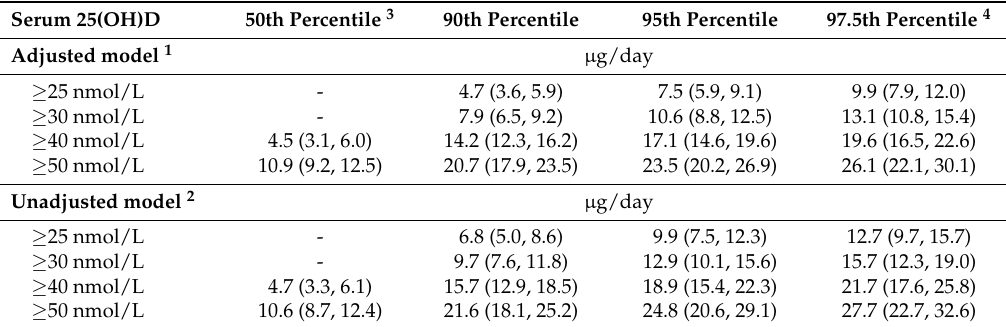
Table 2. Individual Participant Data (IPD) level meta-regression-derived dietary requirements for vitamin D at selected percentiles to maintain serum 25(OH)D above selected concentrations during winter–adjusted and unadjusted